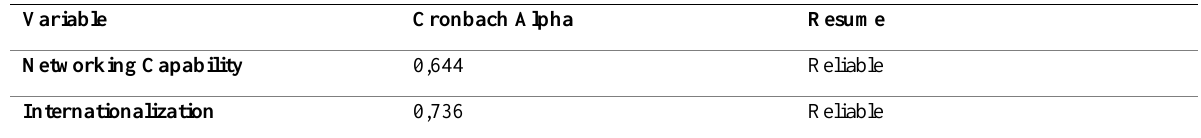
Table 3: Reliability Test